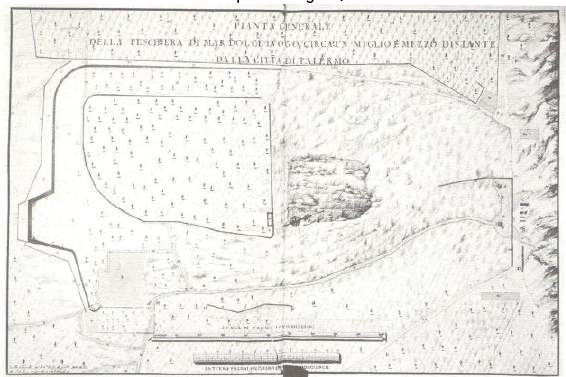
Figure 11. Map of Maredolce site (Chenchi,